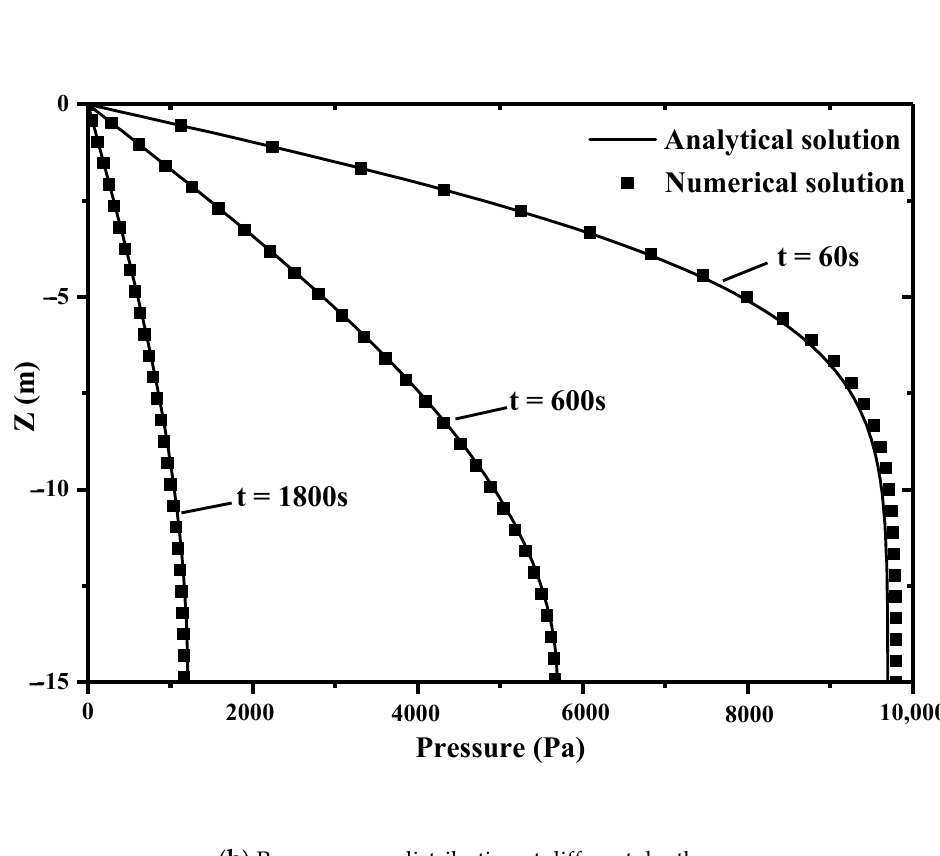
Figure 4. Comparison of our simulations with analytical solutions. (( a ) the relationship between depth and displacement. ( b ) the relationship between depth and